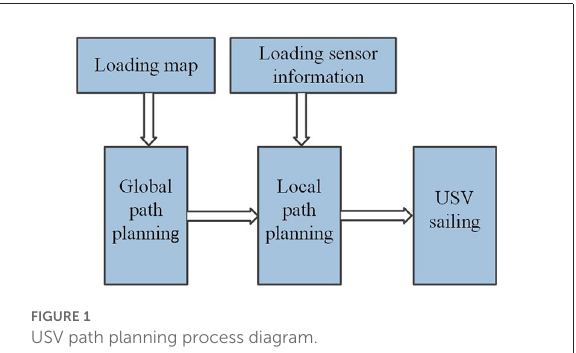
FIGURE1 USV path planning process